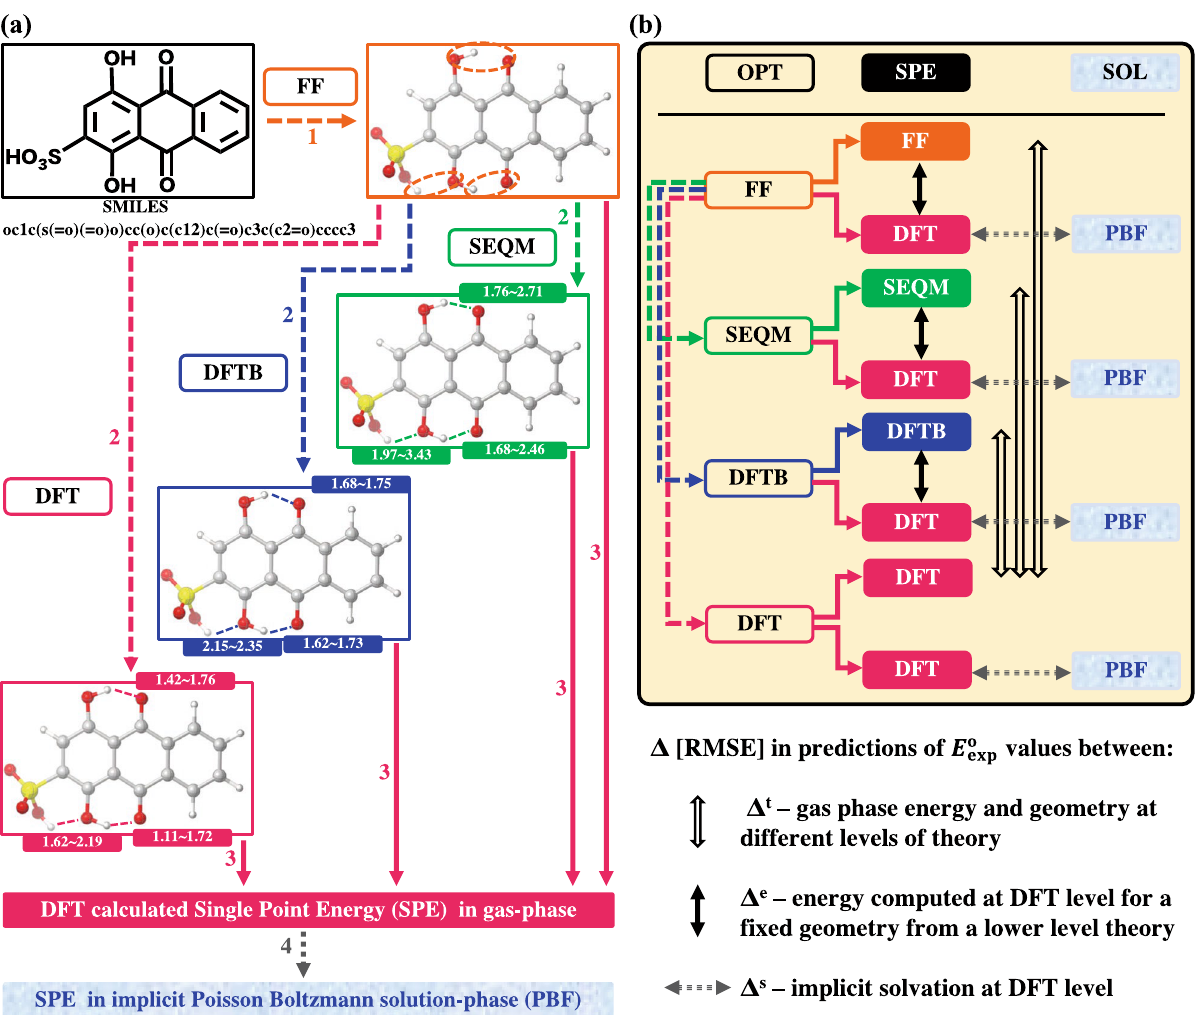
Figure 1. ( a ) Schematic showing the chain of operations for geometry optimization (OPT) and single point energy (SPE) calculations at different levels of theory ( b ) A graphical summary of the various levels of approximations used to estimate (cid:31) E DFT rxn . The hollow black arrows with symbol Δ t represent the difference between gas-phase reaction energies of the optimized geometries obtained at different levels of theory. The solid black arrows with symbol Δ e represent the difference between energies computed using DFT on a fixed geometry obtained from a lower-level theory and energies computed at that given level of theory. The dotted gray arrows represent the solvation effect from gas-phase SPE to solution-phase SPE, when the implicit solvation model is considered. For both ( a , b ), the text boxes with no background color represent geometry optimizations; the boxes with colored background represent SPE calculations; the boxes with water bubbles in the background represent solution-phase SPE calculations using the implicit aqueous solvent